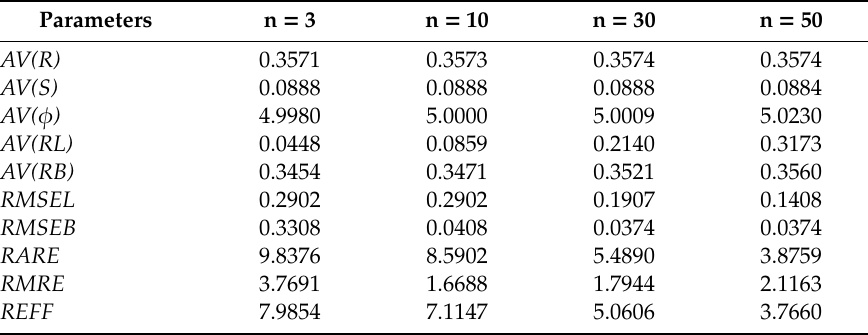
Table 7. Simulation results for cases B’22.